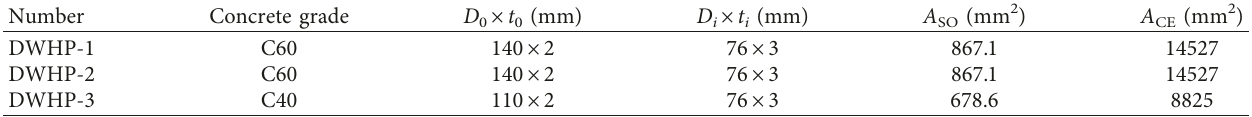
Table 1: Geometric parameters of specimens.